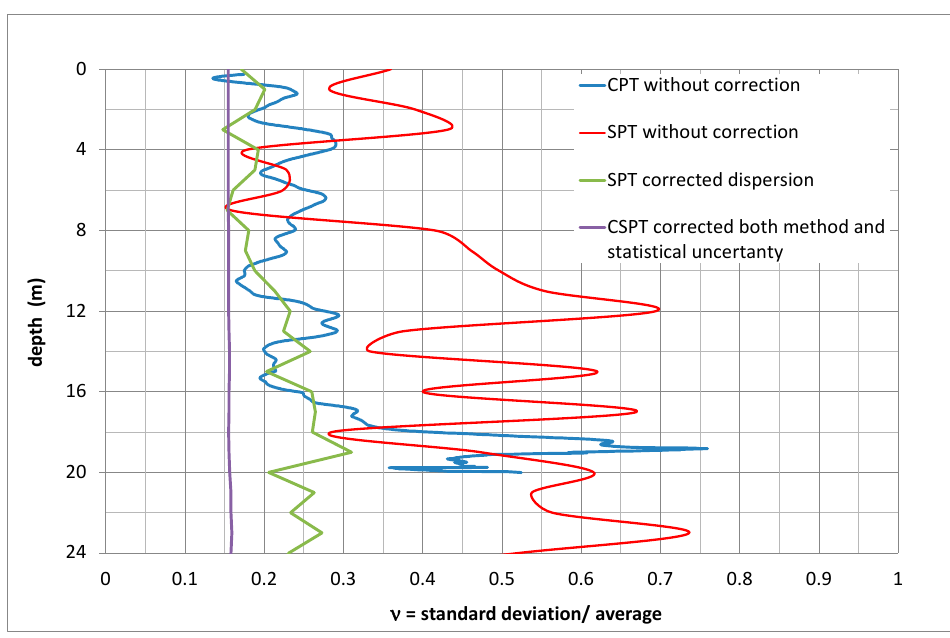
Figure 3. Dispersion with SPT corrected by method and statistical uncertainty.